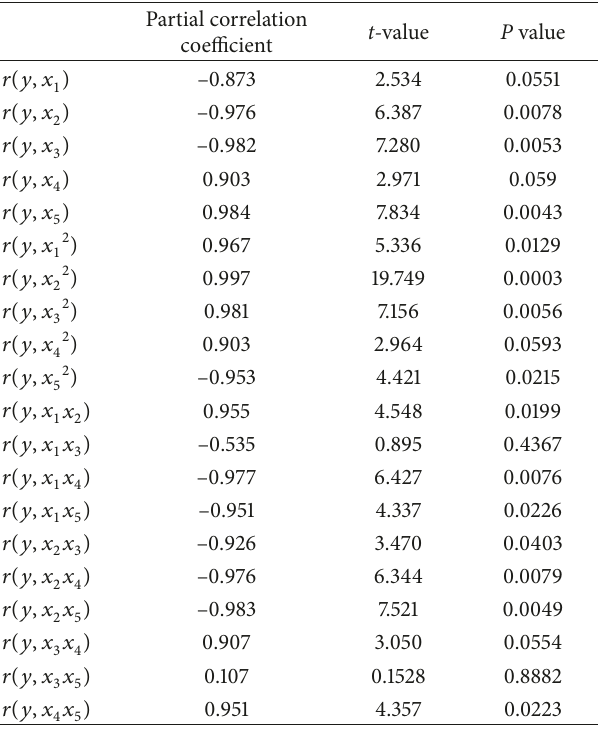
Table 2: Partial correlation analysis of regression coefficient. Partial